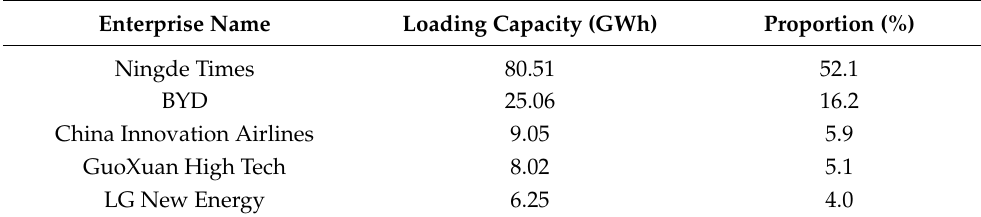
Table 1. Loading capacity and proportion of Chinese top five power battery enterprises.